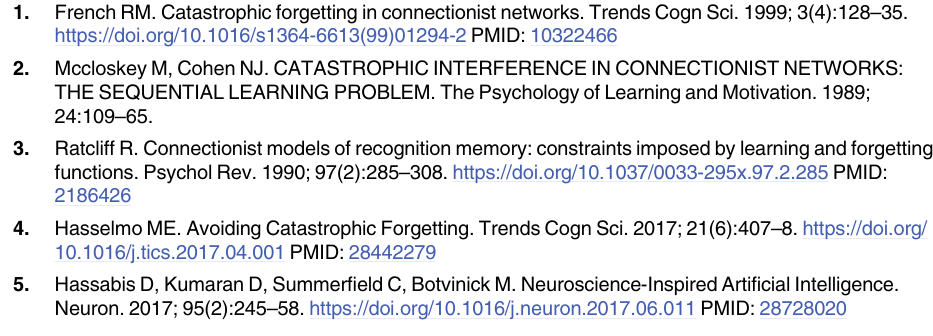
S6 Fig. Freezing a fraction of task specific strong synapses preserves differing degrees of performance in a sequential learning paradigm. (A-C) Mean and standard deviation of per- formance during testing on Task 1 (blue) and Task 2 (red). Left, Performance after Task 1 training. Right, Performance after Task 2 training when a fraction of the strongest (after Task 1 training) synapses remained frozen– 1% (A), 5% (B), 10% (C). In all cases, after Task 1 train- ing, Task 1 performance was 0.70 ± 0.02 and Task 2 performance was 0.53 ± 0.02. (A) Freezing the top 1% of Task 1 synapses resulted in a Task 1 performance of 0.54 ± 0.02 and Task 2 per- formance of 0.68 ± 0.03. (B) Freezing the top 5% of Task 1 synapses resulted in a Task 1 perfor- mance of 0.65 ± 0.02 and Task 2 performance of 0.61 ± 0.01. (C) Freezing the top 10% of Task 1 synapses resulted in a Task 1 performance of 0.70 ± 0.03 and Task 2 performance of 0.53 ± 0.03. Freezing the top 1% of Task 1 synapses was not sufficient to maintain Task 1 per- formance, thus enabling Task 2 relevant synapses to dominate the network; however, freezing the top 10% of Task 1 synapses fully retains Task 1 performance preventing Task 2 to be learned.